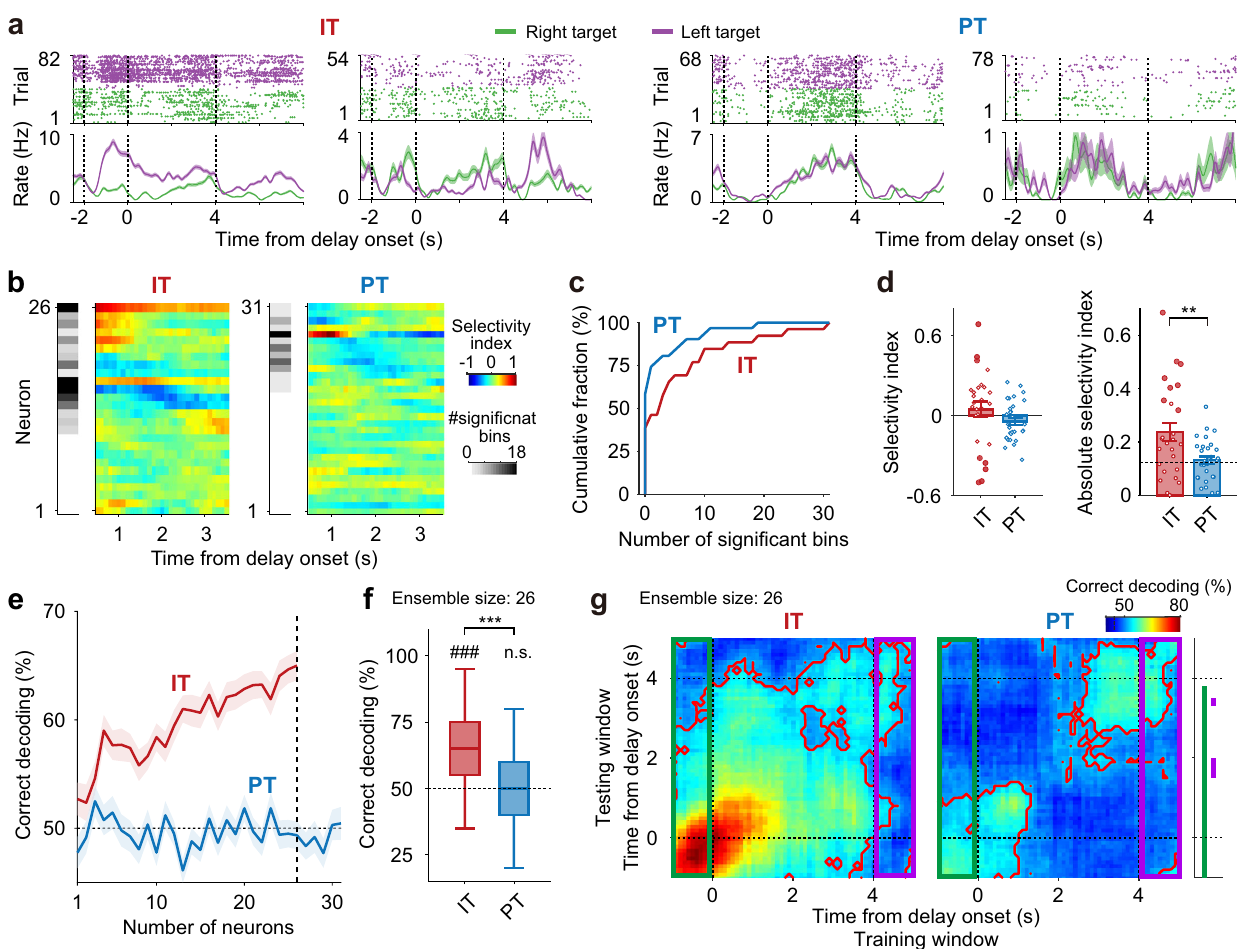
Fig. 3 IT neurons convey stronger target signals than PT neurons. Target-selectivity of delay-period activity was compared between IT and PT neurons using correct trials. a Example IT and PT neuronal responses during the fi xed-delay (4 s) condition (correct trials only). Top, spike raster plots; bottom, spike density functions ( σ = 100 ms). Green, right-target trials; purple, left-target trials. b Heat maps showing target-dependent fi ring (target selectivity index; 1-s window advanced in 0.1 s steps) of all analyzed IT and PT neurons. Red and blue denote higher fi ring in ipsilateral- and contralateral-target trials, respectively. The number of bins with signi fi cant target-dependent fi ring ( p < 0.05, t -test) is indicated in gray scale for each neuron on the left. Neurons were sorted according to the time of absolute peak selectivity index. c Cumulative plots for the number of bins with signi fi cant target-dependent fi ring. d Distributions of target selectivity index (left; positive and negative, preferential fi ring toward ipsilateral and contralateral targets, respectively) and absolute target selectivity index (right). Dotted line represents mean target-dependent fi ring calculated with trial-shuf fl ed data. Circles denote individual neurons (IT, n = 26, PT, n = 31 neurons) and fi lled circles indicate neurons with a signi fi cant selectivity index ( p < 0.05, t -test). ** p < 0.01 (IT versus PT, t -test). e Neural decoding of target as a function of ensemble size. f Decoding performance at ensemble size of 26 neurons (vertical dashed line in e ).